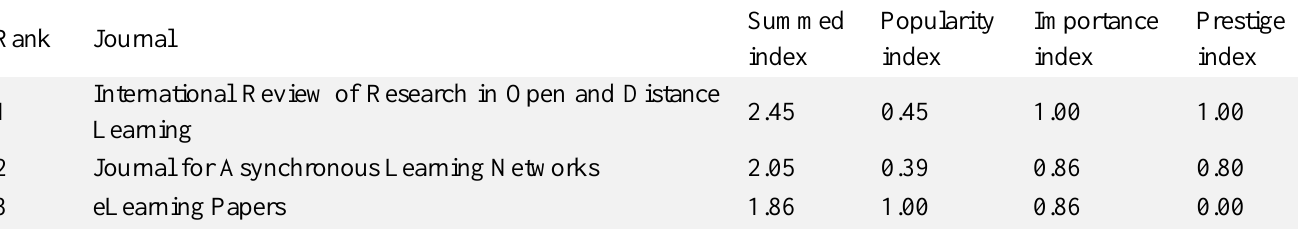
Overall Ranking of Scholarly CML Journals (N =